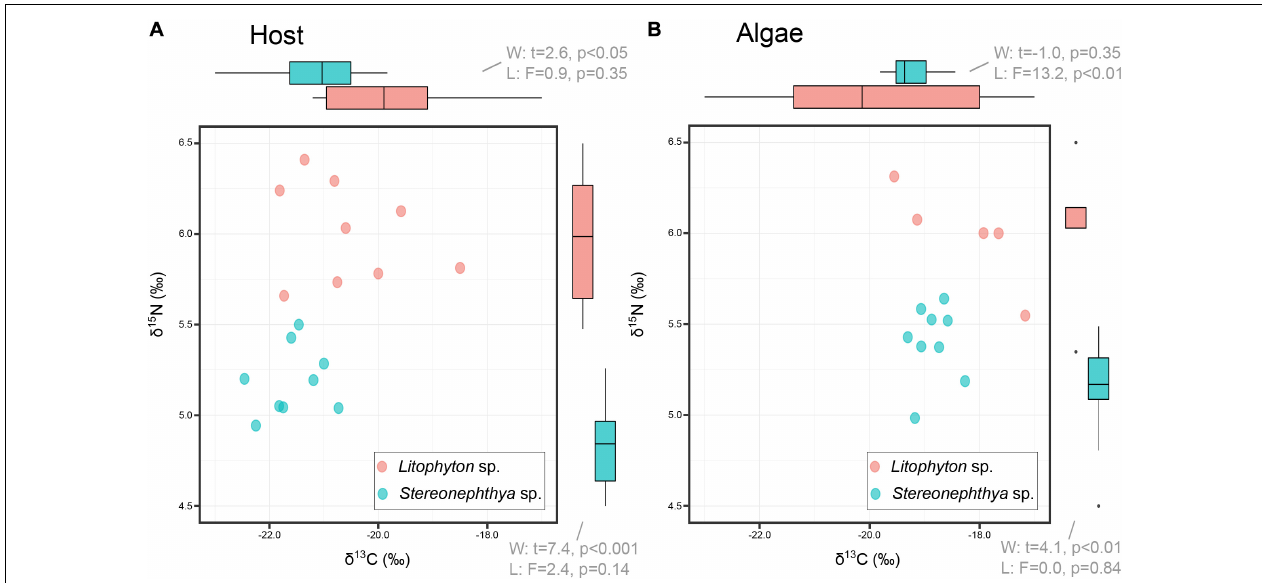
FIGURE 3 | Carbon ( δ 13 C) and nitrogen ( δ 15 N) comparison between octocoral hosts (A) and their associated algae (B) . Bi-plots only display full case samples, while boxplot in margins incorporates all measurements available for the variable of